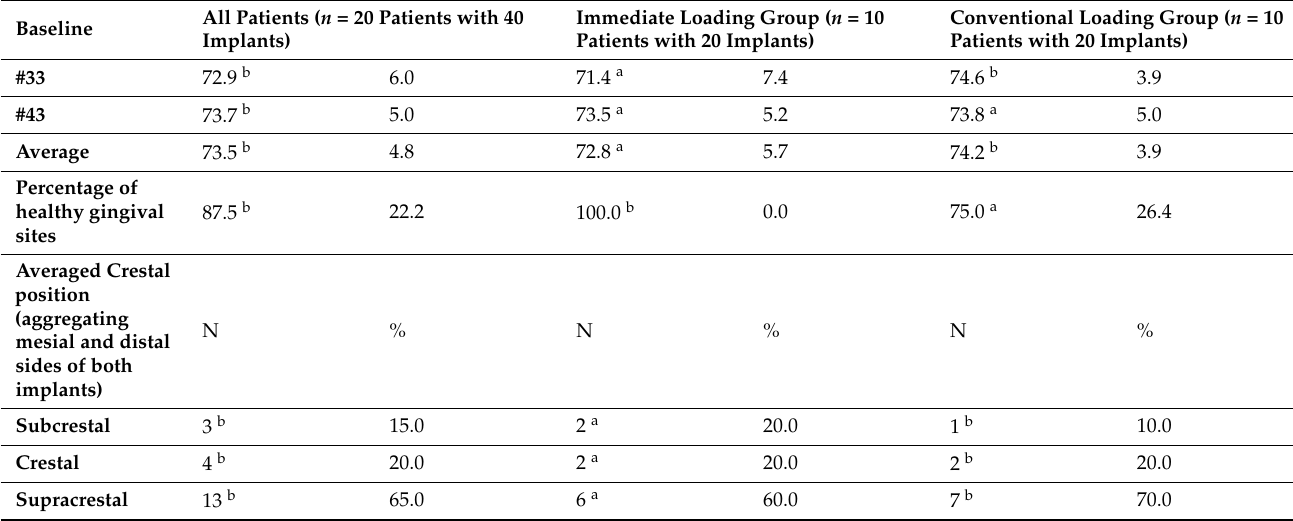
Table 3 contains the marginal bone loss values one year after implant placement.